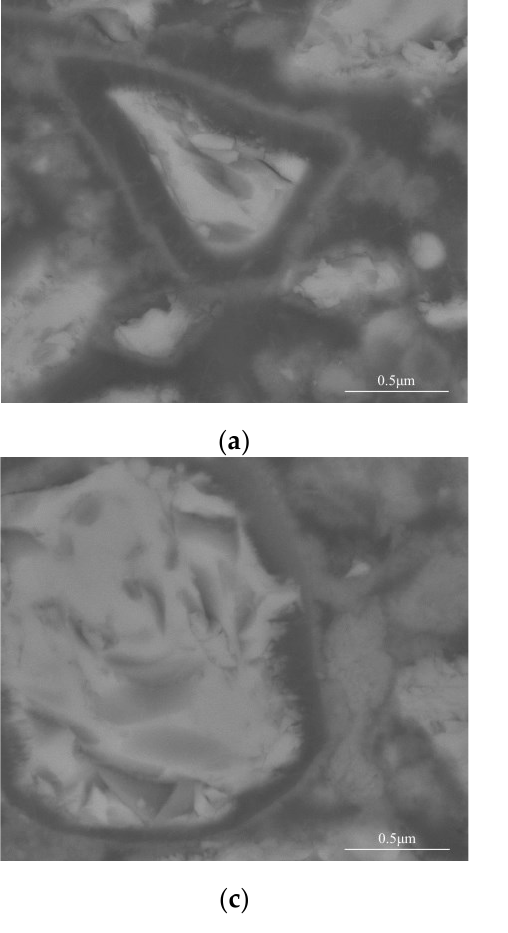
Figure 3. Microstructure evolution of autolytic clinker microspheres at ( a ) curing room for 1 day, ( b ) curing room for 1 day and then water curing for 4 h, ( c ) curing room for 1 day and then water curing for 24 h, ( d ) curing room for 1 day and then water curing for 48 h. Table 3. Mass distribution of major elements in different points from Figure